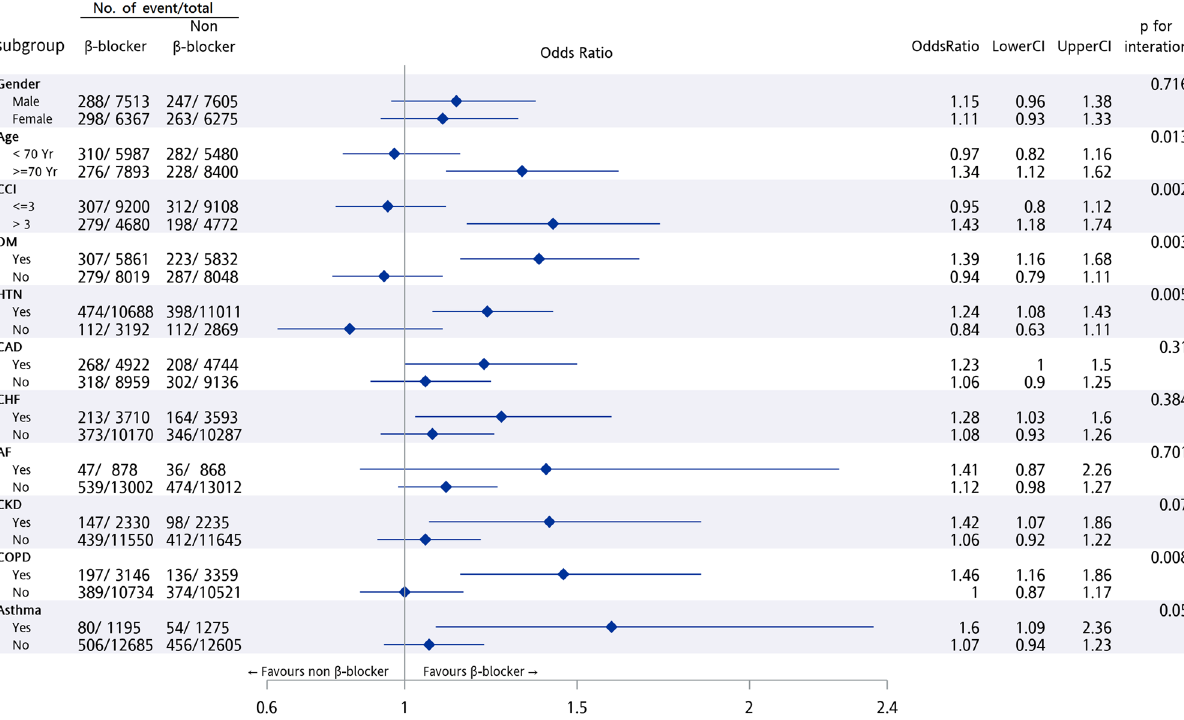
Figure 3. Subgroup analysis among prior ß-blockers use before cardiac arrest, clinical characteristics, and one- year survival (* P <